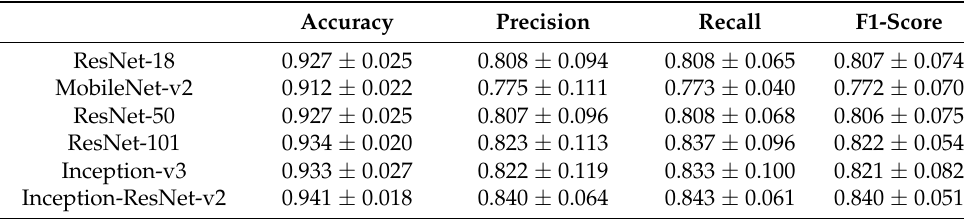
Figure 2. The confusion matrix of the CNN-based deep learning models for determination of CVM stages. ( a ) ResNet18; ( b ) MobileNet-v2; ( c ) ResNet-50; ( d ) ResNet-101; ( e ) Inception-v3; ( f ) Inception-ResNet-v2. Table 3. Accuracy, precision, recall, and F1-score corresponding to the CNN-based deep learning models. Values presented in the table are in the format of mean ± standard deviation.